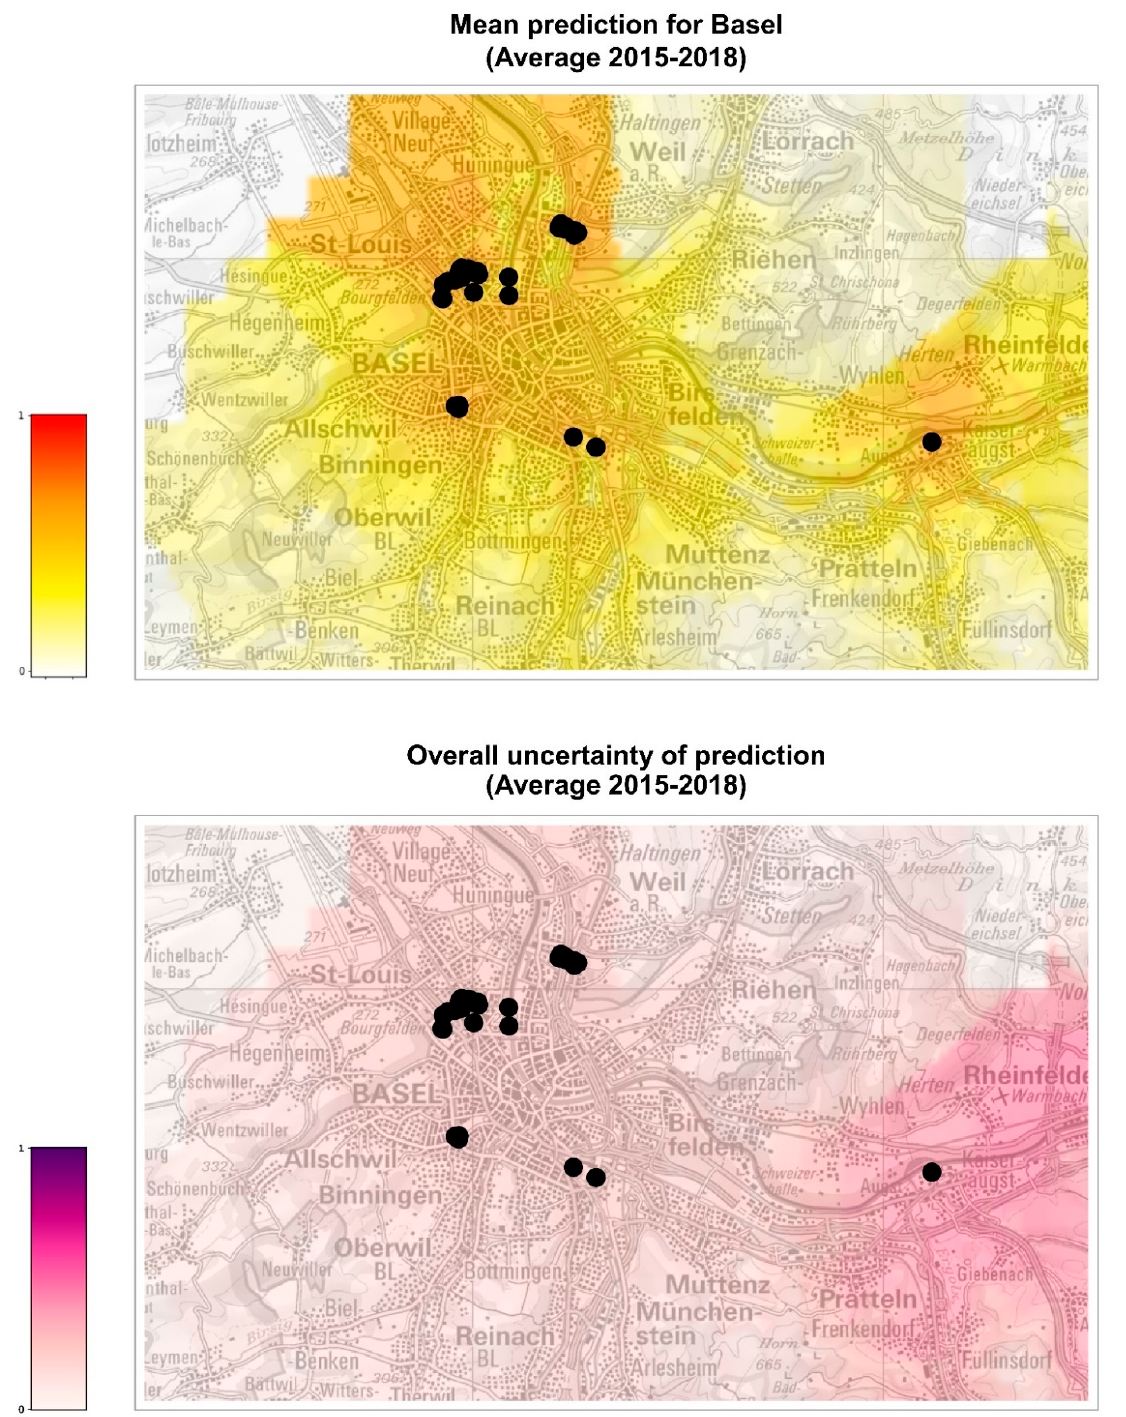
Figure 4. Probabilities of establishment of Ae. albopictus in Basel. The map on top shows the average risk estimate over the years 2015–2018. The color gradient shows the probability of establishment from 0 (white) to 1 (red). The bottom map represents the uncertainty of the prediction (higher values representing more uncertain predictions). Black dots show the positions where Ae. albopictus was established in 2019, which are used to compute the feature car distance to establishment (distance from the closest cell with establishment in the previous year). Maps modified from https://map.geoadmin.ch/ (accessed on 24 February 2022).